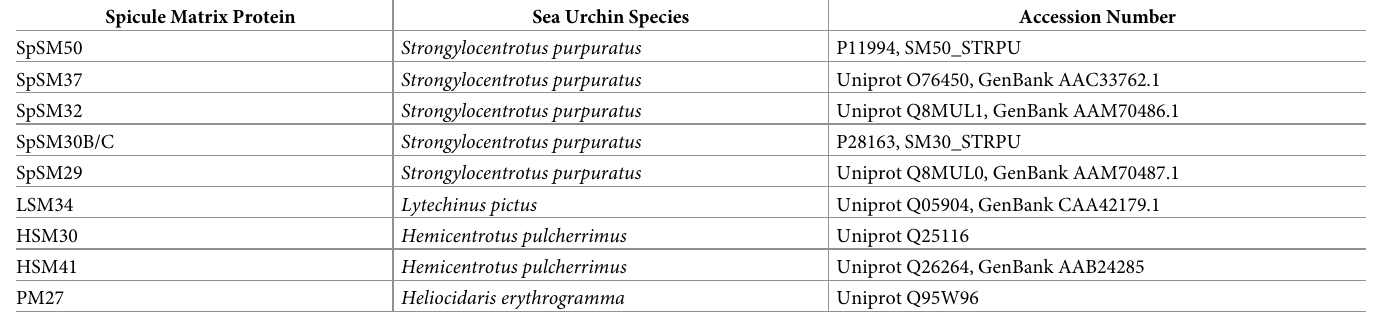
Table 1. Spicule matrix protein